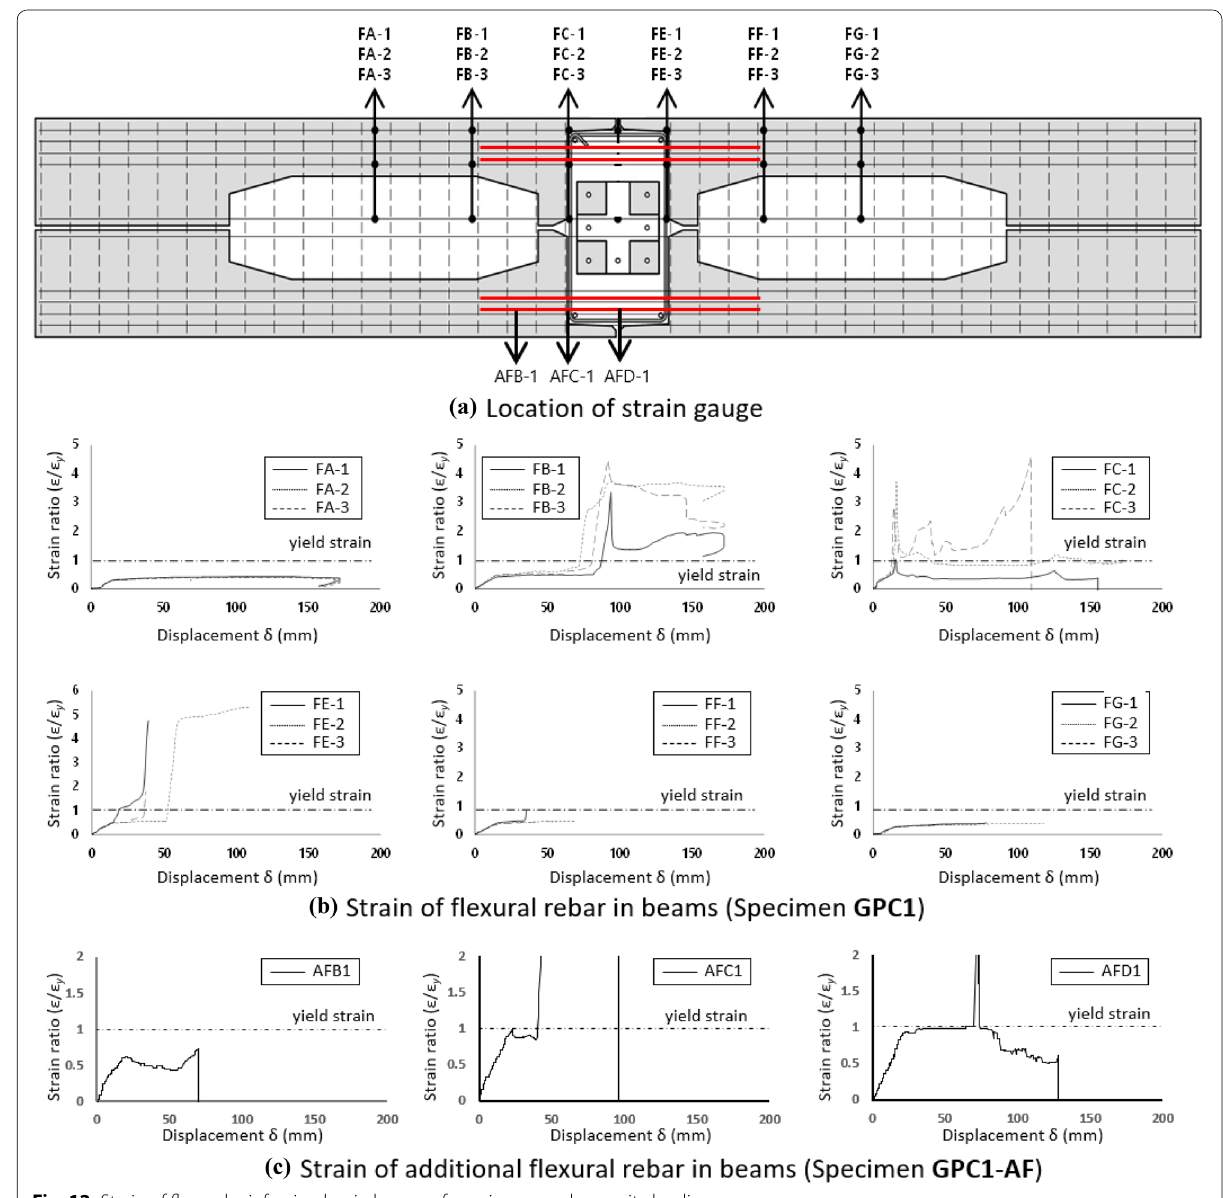
Fig. 12 Strain of flexural reinforcing bar in beams of specimens under gravity